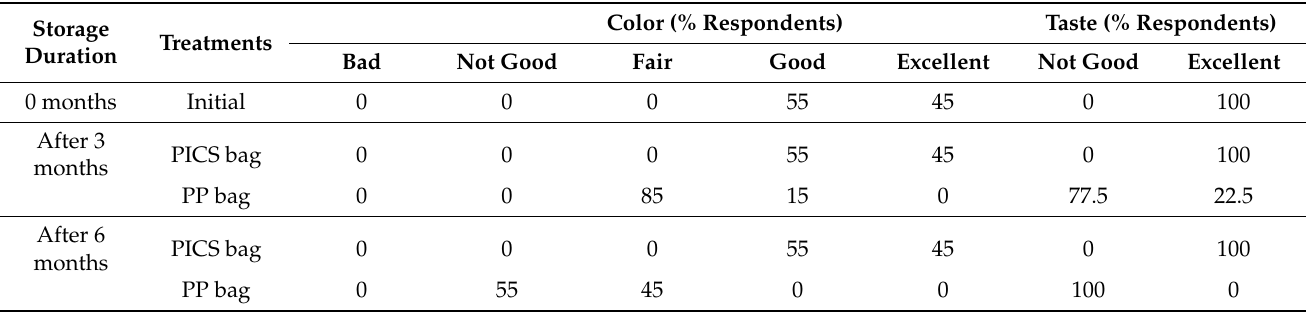
Table 3. Assessment of the color and taste of bread made with wheat flour stored in Purdue Improved Crop Storage (PICS) and polypropylene (PP) bags for three and six months in Herat Afghanistan.